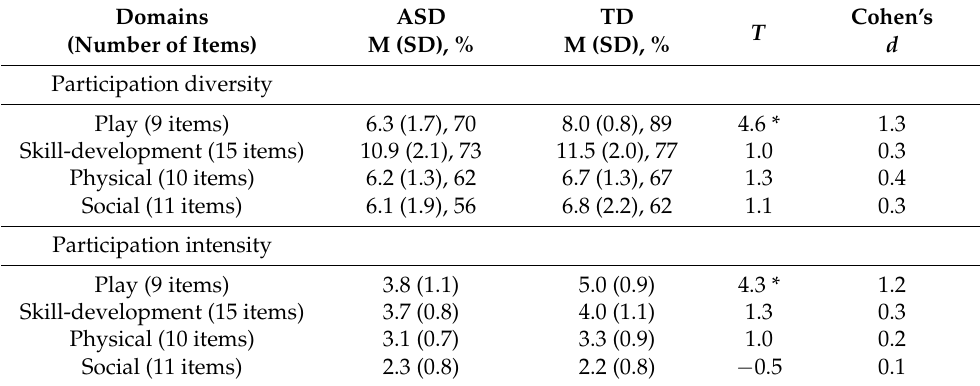
Table 3. Comparisons of APCP-C Mean Scores between Children with ASD and TD